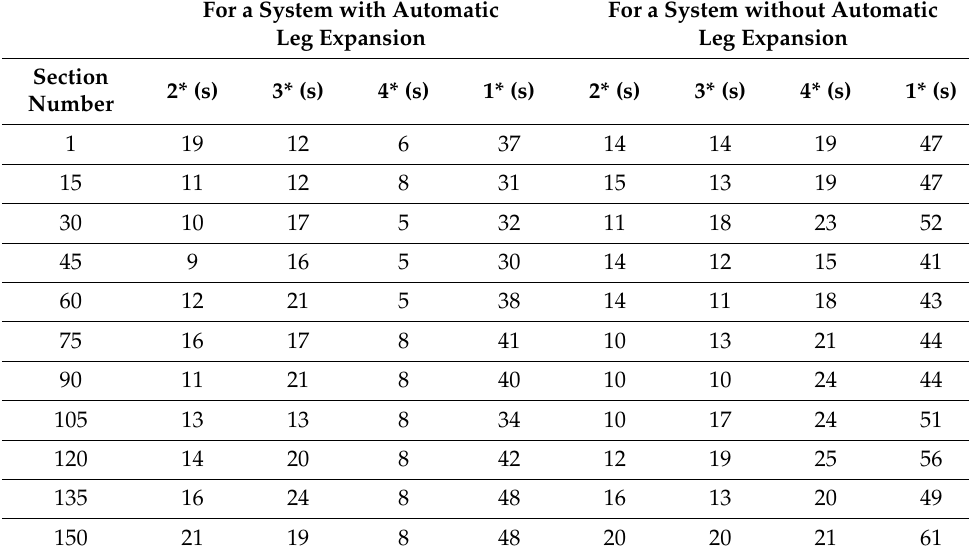
Table 1. Working-cycle times of sections (1*) for a powered support equipped with an automatic leg-expansion system and a support without the system—divided into the leg withdrawal (2*), readjustment (3*) and section-expansion phase (4*). For a System with Automatic For a System without Automatic Leg Expansion Leg Expansion